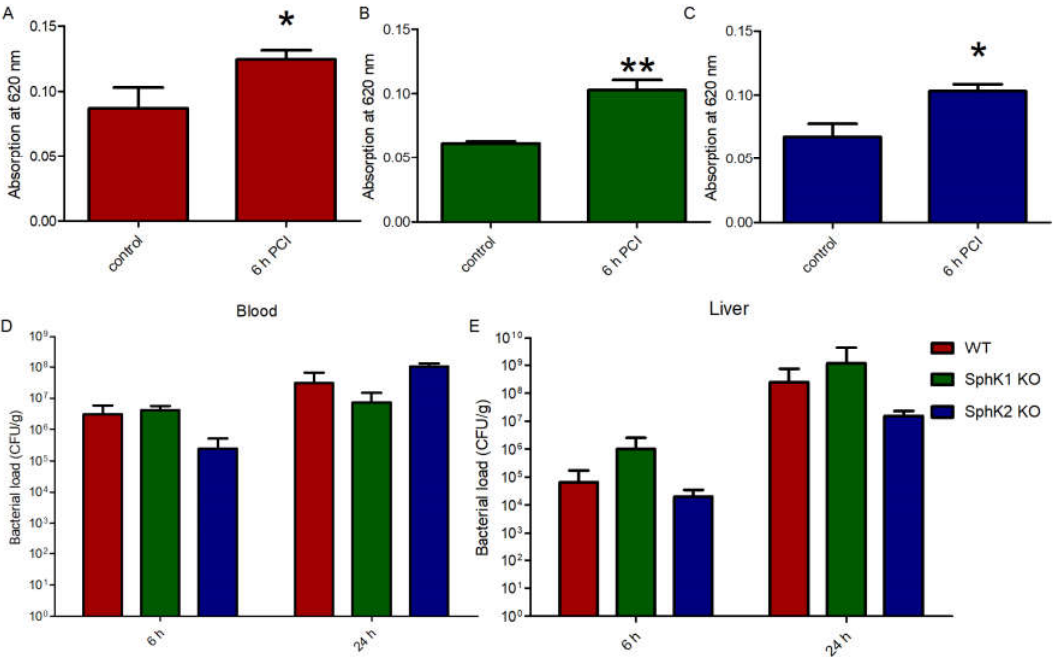
Figure 3. Determination of the VEC barrier stability using Evans blue injection before (control) and 6 h post infection in ( A ) wt, ( B ) SphK1 − / − and ( C ) SphK2 − / − mice. Bacterial load in ( D ) blood and ( E ) liver 6 h and 24 h post infection in wt, SphK1 − / − and SphK2 − / − mice. Significances were calculated ( A – C ) between control and infected mice or ( D , E ) wt and SphK deficient mice using the two-tailed unpaired Student’s t -test, n ≥ 3, * p < 0.05, ** p < 0.01.